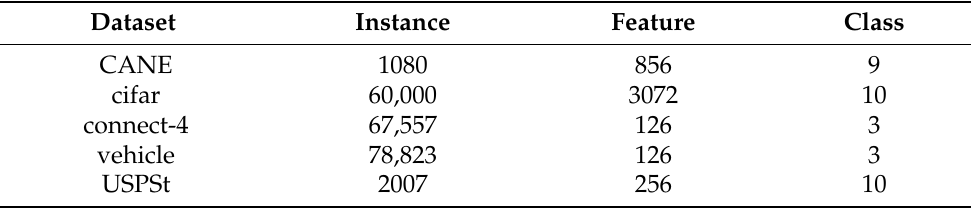
Table 2. Summarization of used data